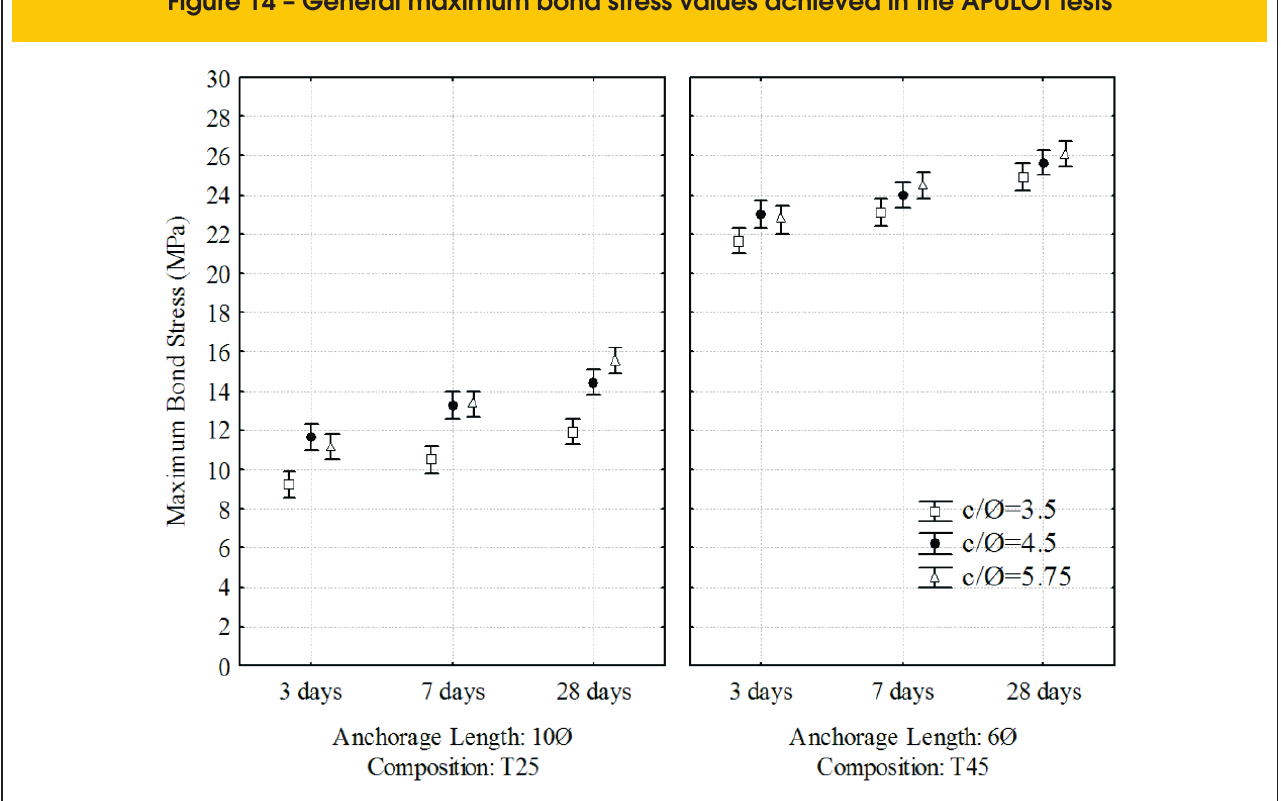
Figure 14 – General maximum bond stress values achieved in the APULOT